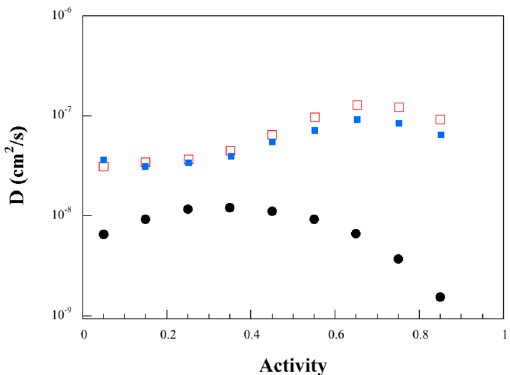
Figure 7. Water diffusivity as a function of water activity; filled circles (larva protein), unfilled squares (wheat gluten 80 °C, average values) [47] and filled squares (wheat gluten 120 °C, averages) [47].